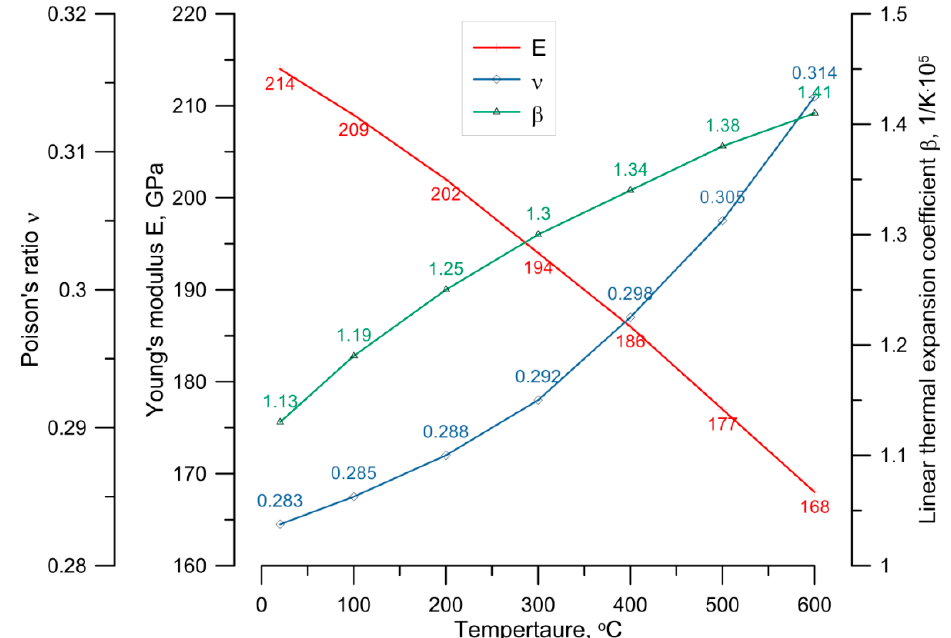
Figure 12. Young’s modulus, Poison’s ratio and linear thermal expansion coefficient for steel 14MoV63 as functions of temperature.